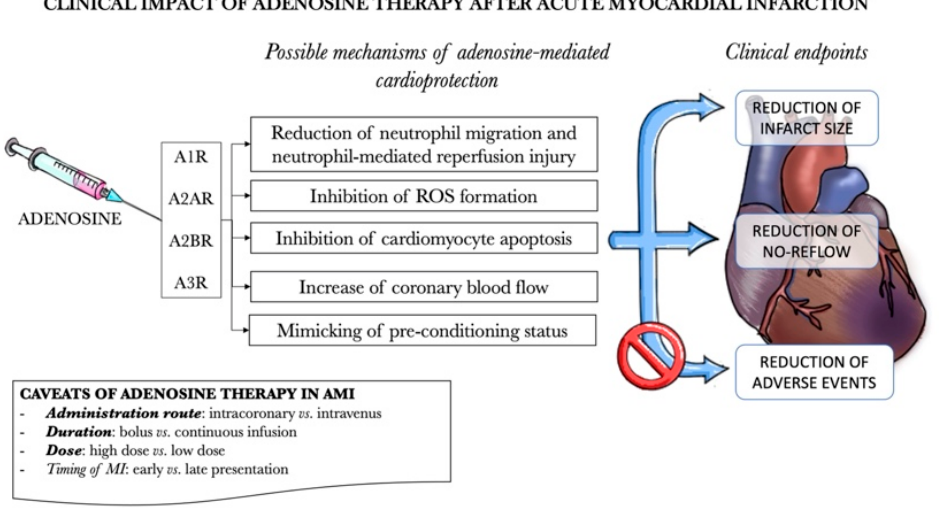
Figure 3. Potential role of adenosine therapy after acute myocardial infarction. Adjunctive adenosine therapy for the management of AMI has been studied in two pivotal clinical trials in humans: Acute Myocardial Infarction STudy of Adenosine (AMIS- TAD) and AMISTAD